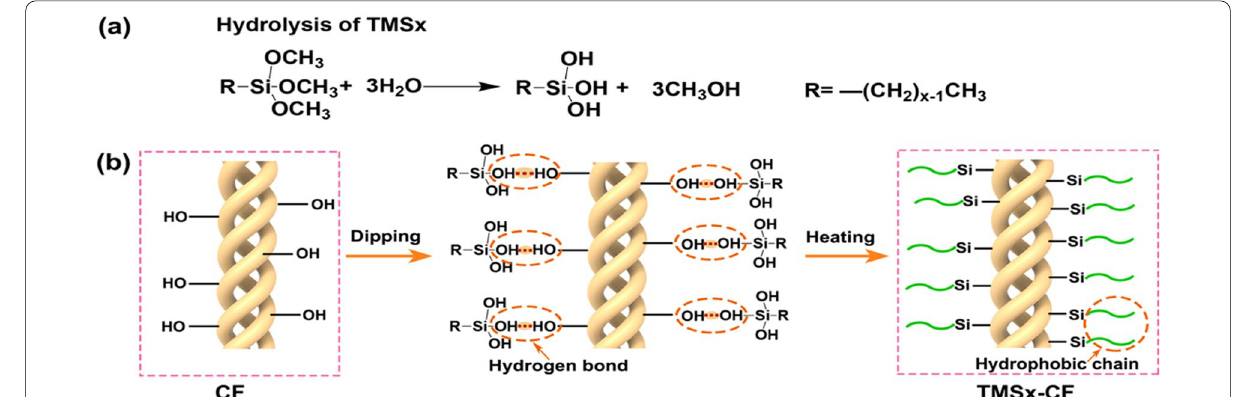
Fig. 1 Schematic illustration showing the fabrication of